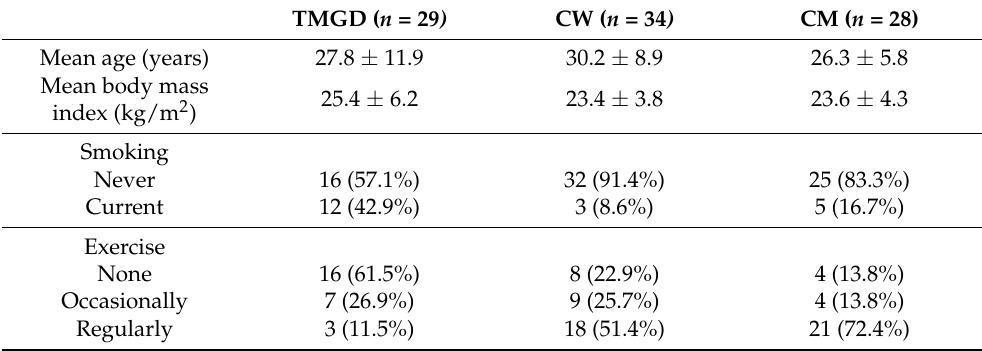
Table 1. Baseline characteristics and distribution of smoking, exercise, drug use, and GD onset in the study